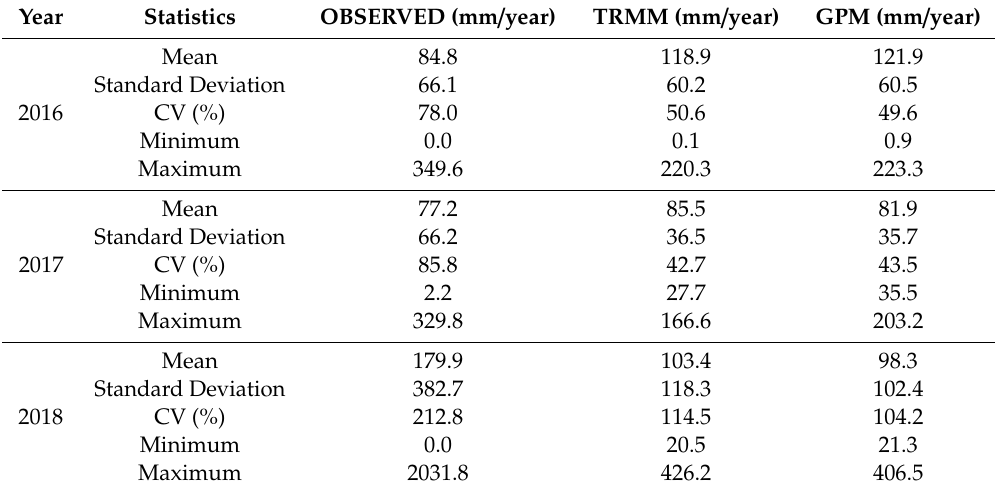
Table 4. Descriptive statistics of gauged and satellite precipitation estimates for